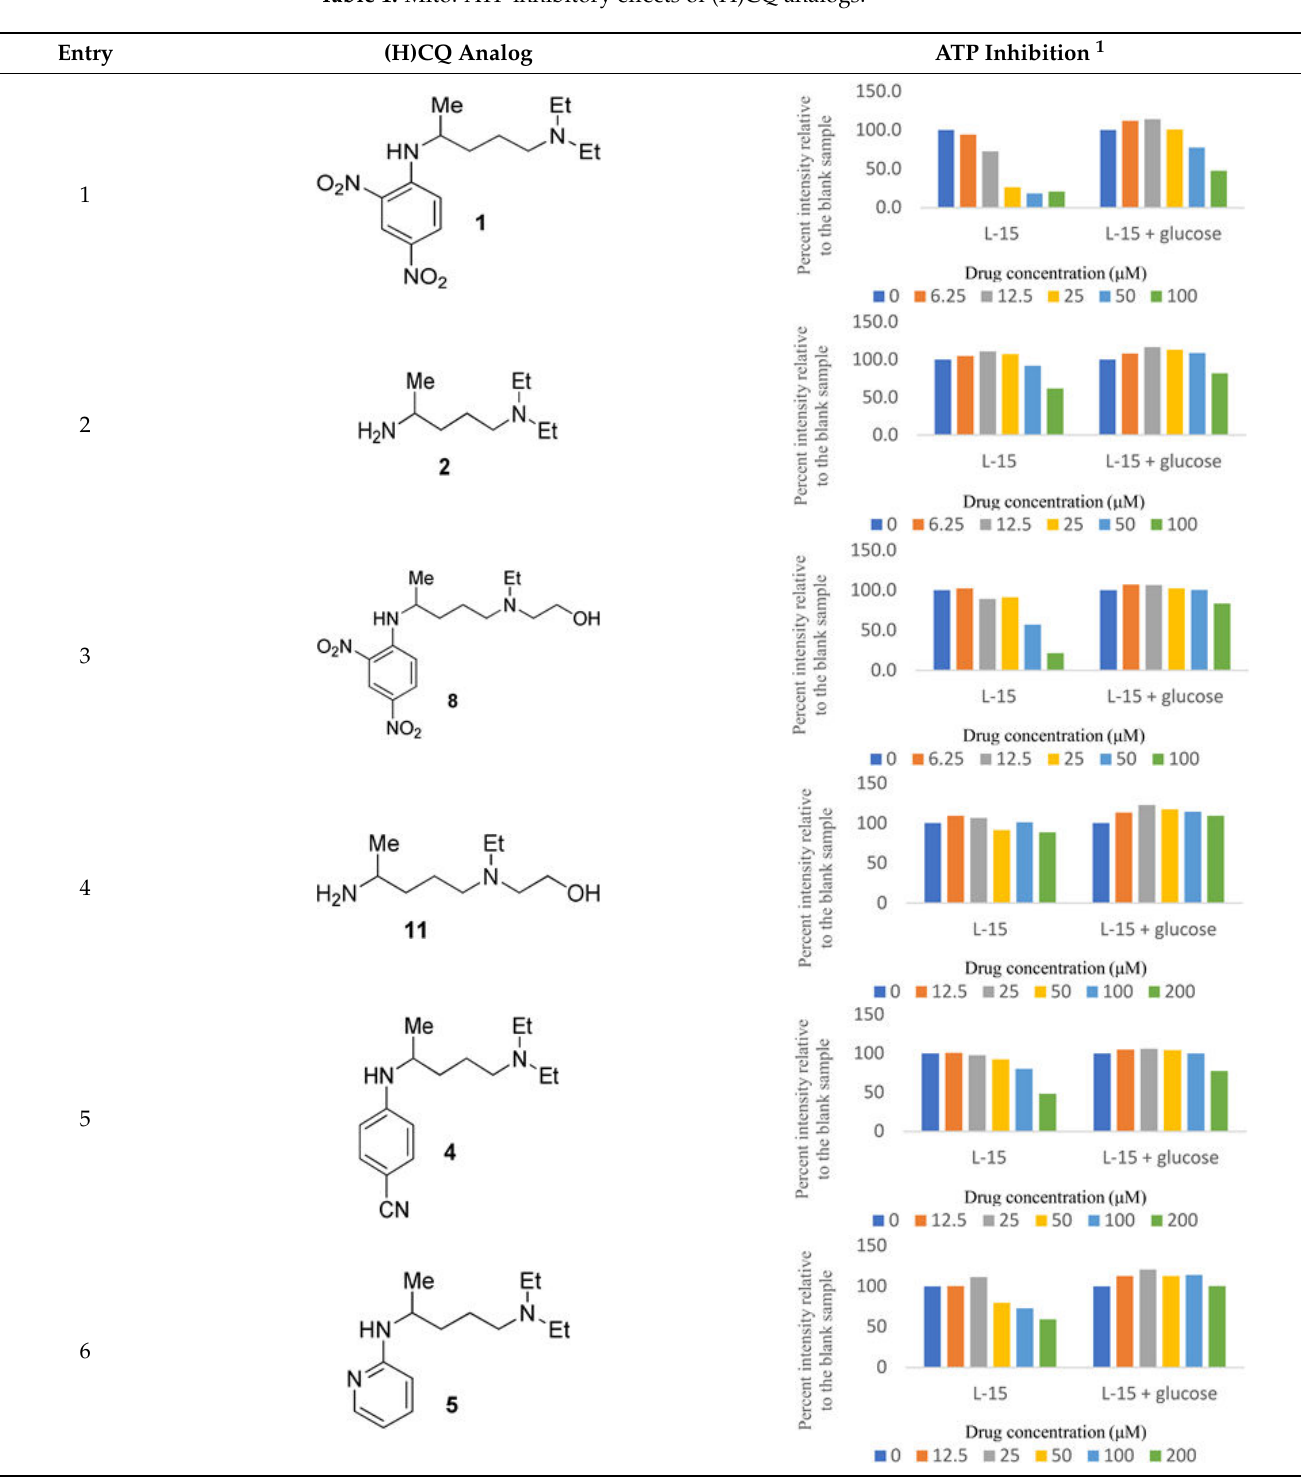
Table 1. Mito. ATP inhibitory effects of (H)CQ